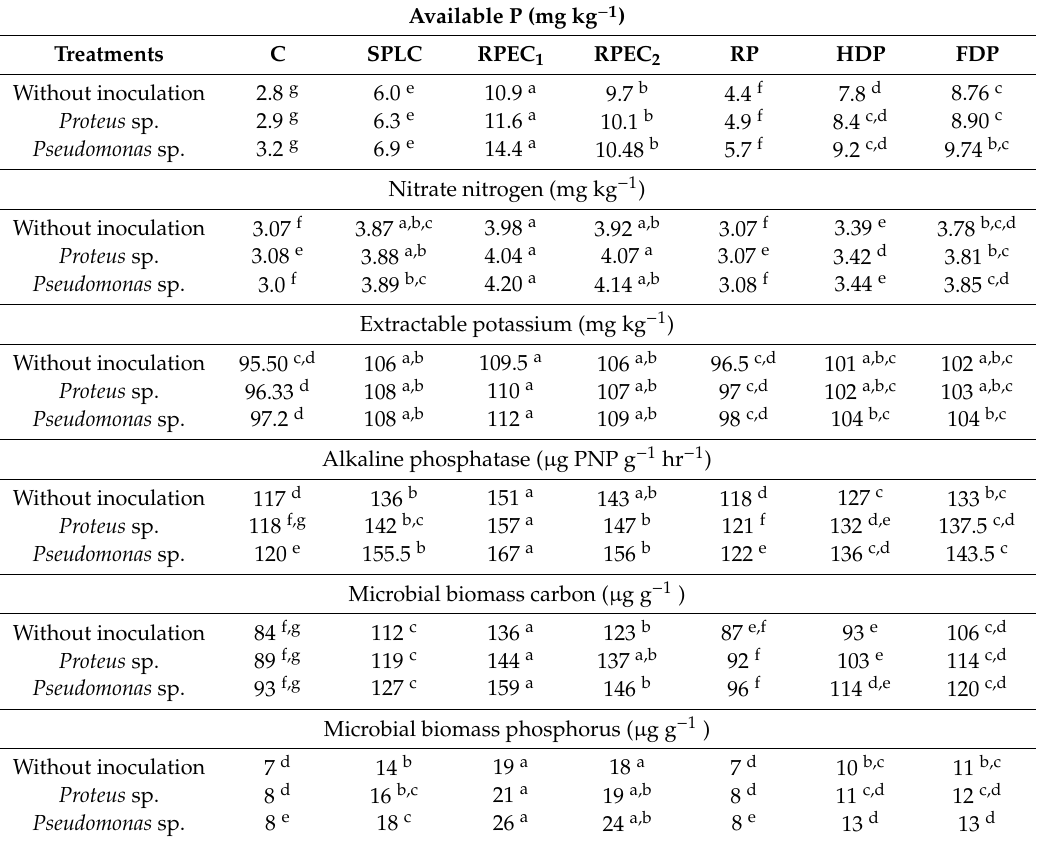
Table 5. E ff ects of PGPR, P-enriched compost and inorganic fertilizers on post-harvest soil of wheat in field